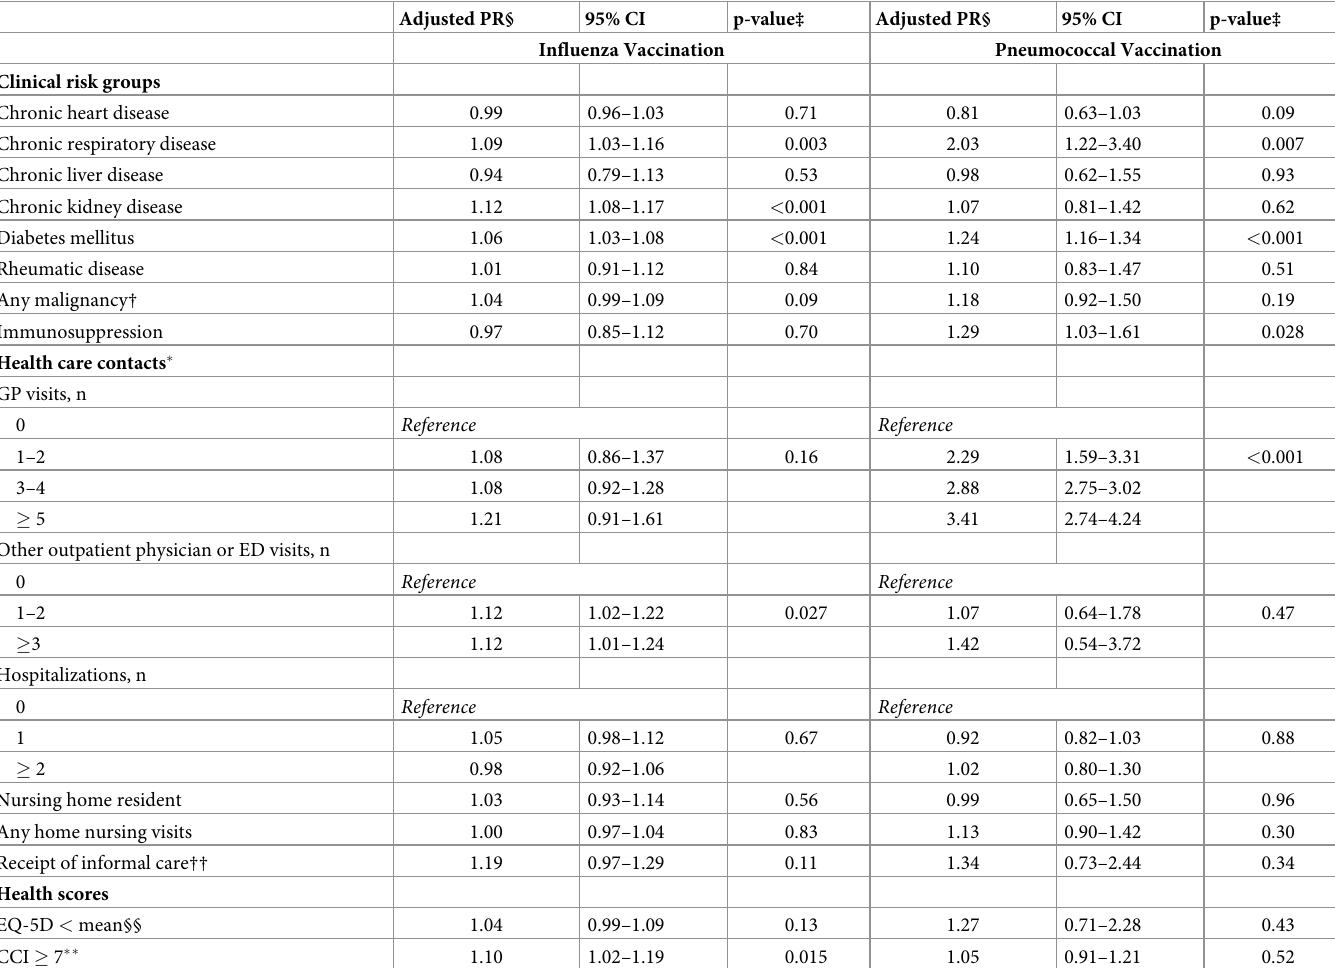
Table 3. Association of chronic health conditions and medical resource utilization with receipt of influenza and pneumococcal